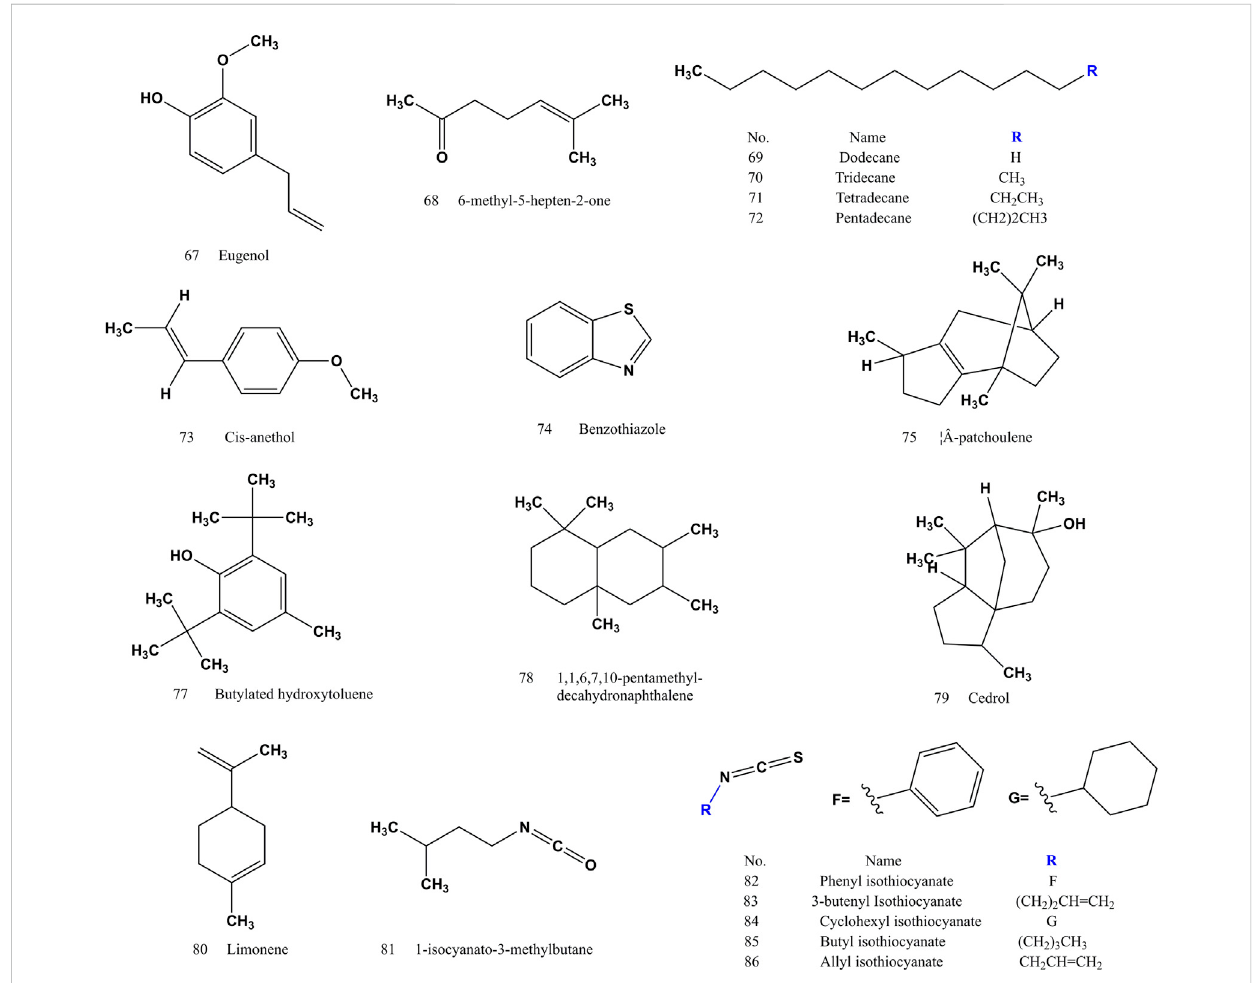
FIGURE 4 Partial chemical structures of volatile oils identi fi ed from SS (compound 67 – 86